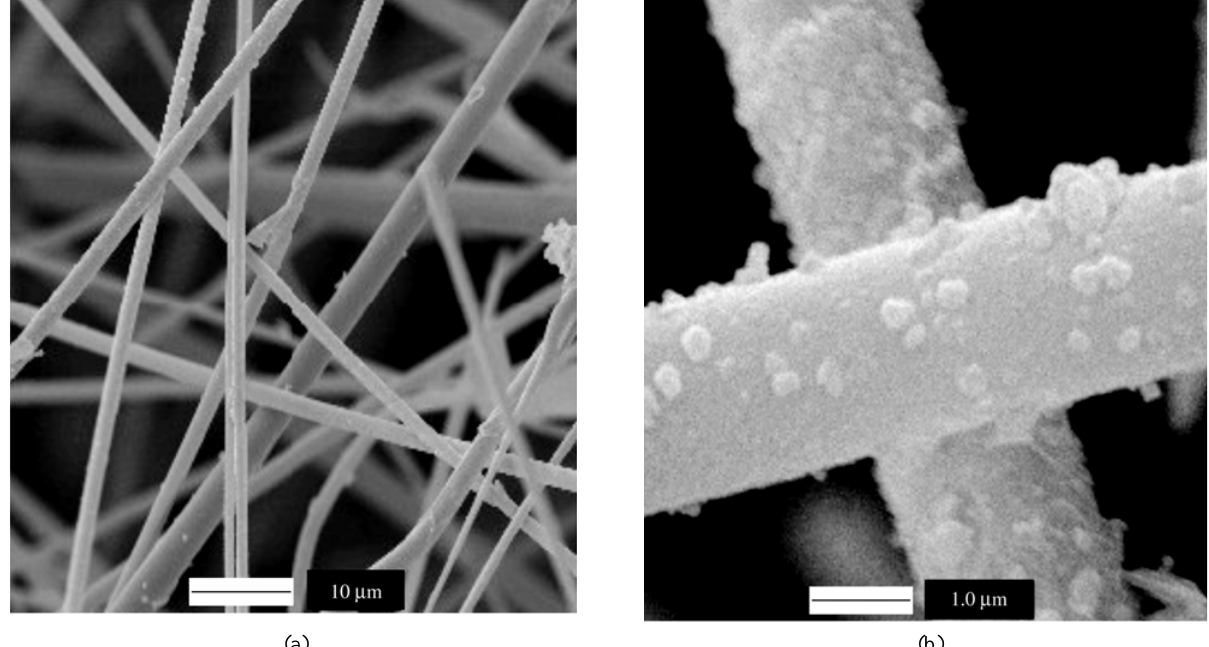
Figure 2. SEM micrographs of FM ® fibers: a) before any chemical treatment, b) after TEOS treatment and immersed for 10 days in SBF